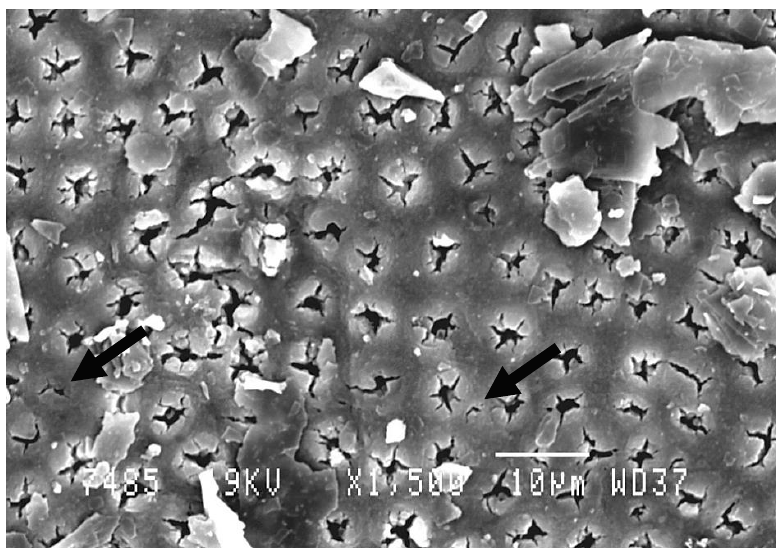
Figure 3. Scanning electron microscopic (SEM) view of unlased dentin (control) treated only with ethylenediaminetetraacetic acid (EDTA) (18%). The dentin is not covered by the smear layer. The tubules are open. Magnification: 1500×.